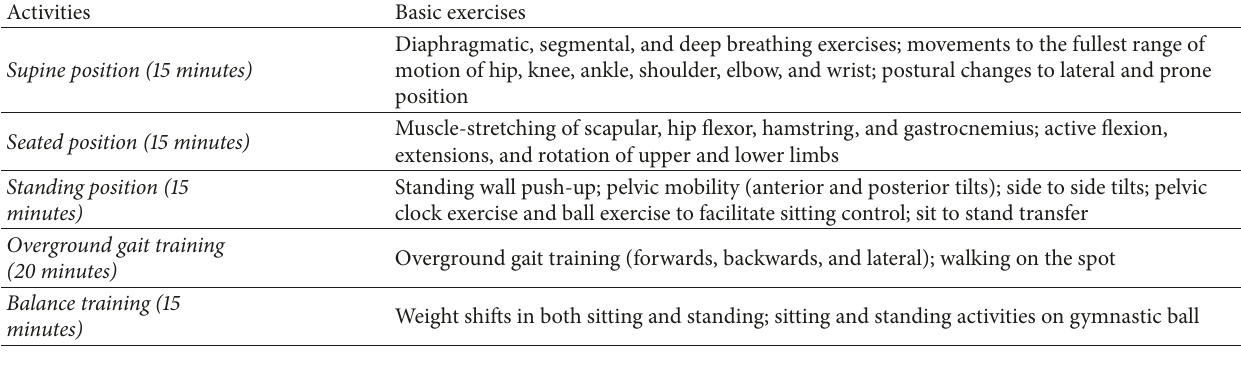
Table 2: Exercises included in the physiotherapy rehabilitation program. Depending on the single patient’s motor and functional status, the physiotherapist could include exercises other than those indicated as basic exercises.